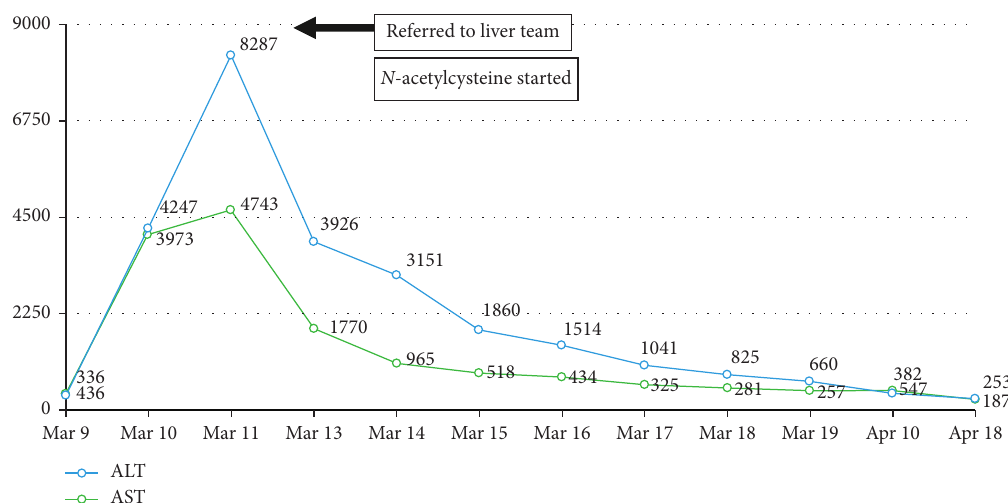
Figure 2: Transaminases trends.